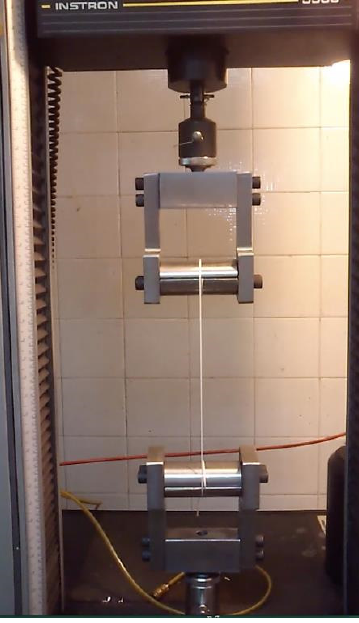
Figure 3. Tensile strength test using Instron tensile testing machine.